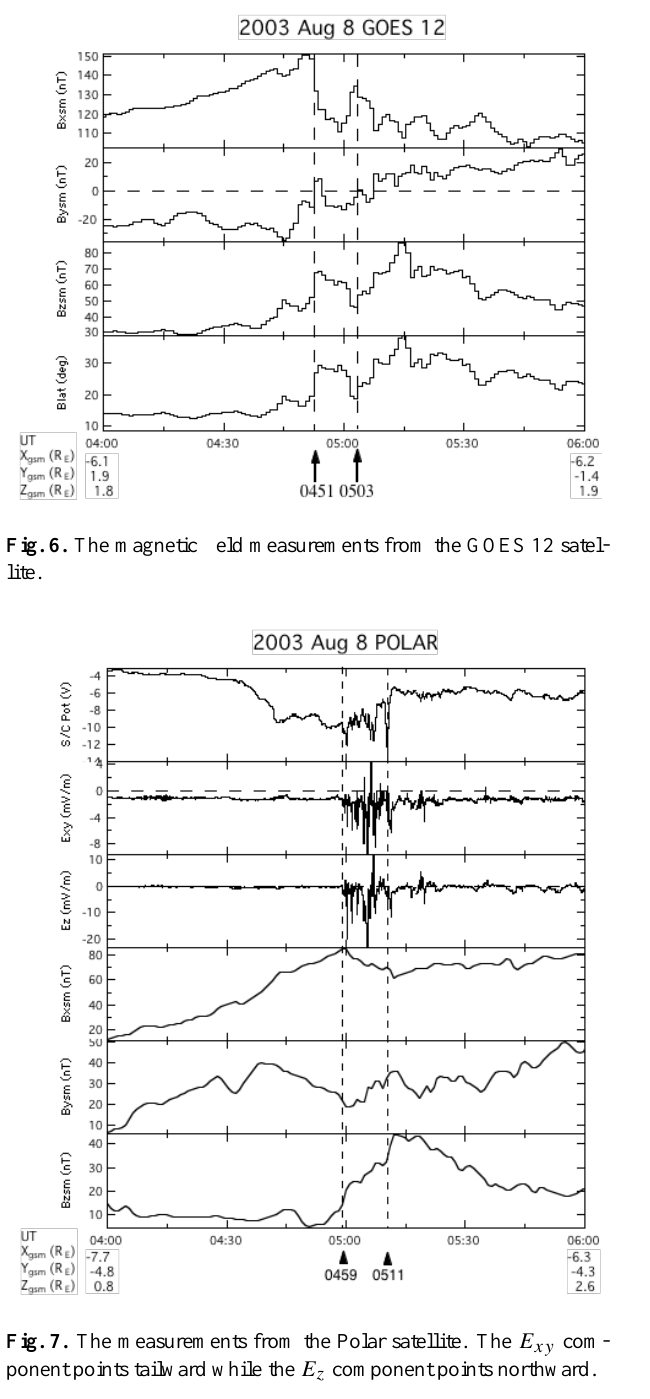
Figure 7 Fig. 7. The measurements from the Polar satellite. The E xy com- ponent points tailward while the E z component points northward.